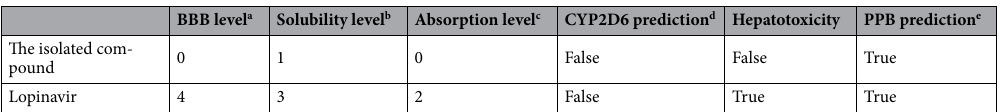
Table 4. The predicted ADMET for the isolated compound and lopinavir. a 0 = very high, 1 = high, 2 = medium, 3 = low, 4 = very low. b 1 = very low, 2 = low, 3 = good, 4 = optimal. c 0 = good, 1 = moderate, 2 = poor, 3 = very poor. d TRUE = inhibitor, FALSE = non inhibitor. e FALSE means less than 90%, TRUE means more than